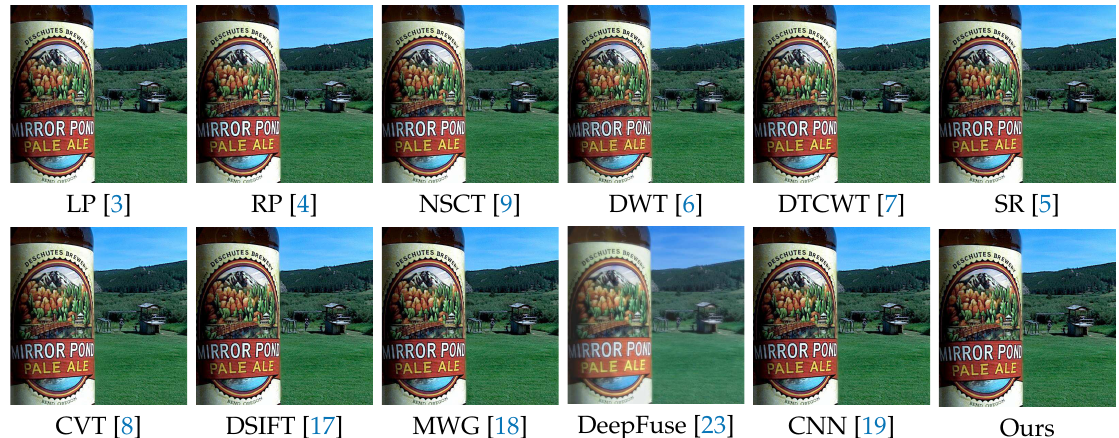
Figure 7. The fusion results of ’Lytro-09’ using various